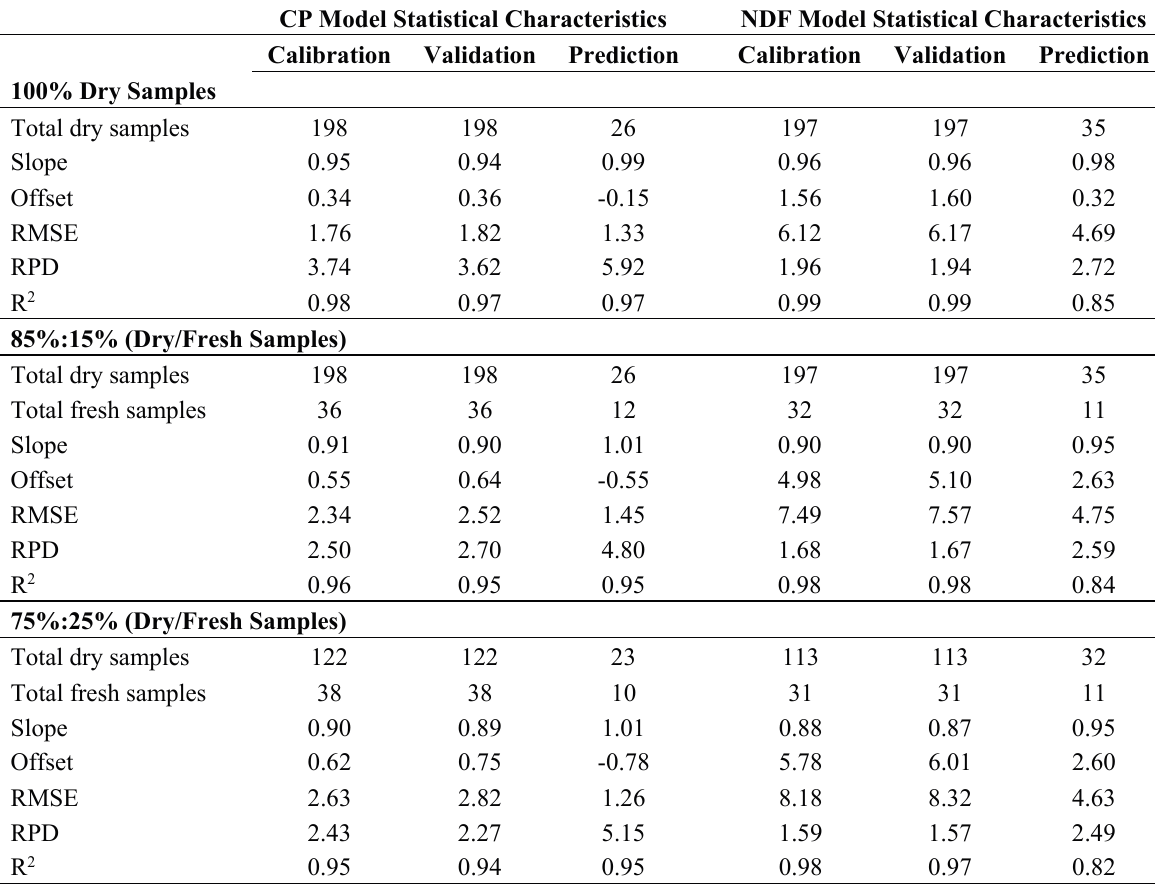
Table 2. Partial least squares (PLS) regression model results of different ratios of dry to fresh vegetation samples and predicted crude protein (CP) and neutral detergent fiber (NDF)